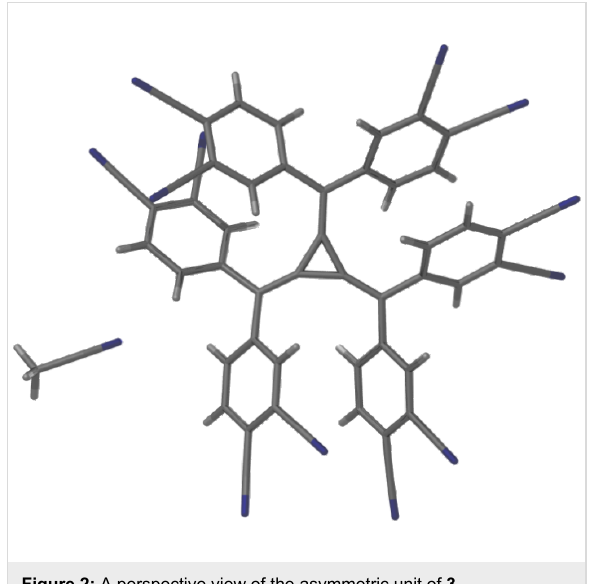
Figure 2: A perspective view of the asymmetric unit of 3 .